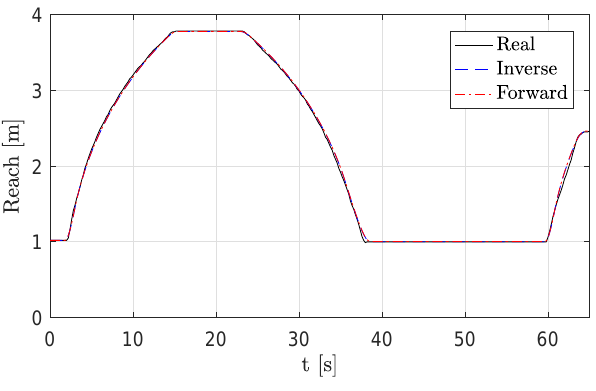
Figure 12: Gripper arm reach position. The results show that the modeled reach position closely resembles the position of the full-scale reference machine.